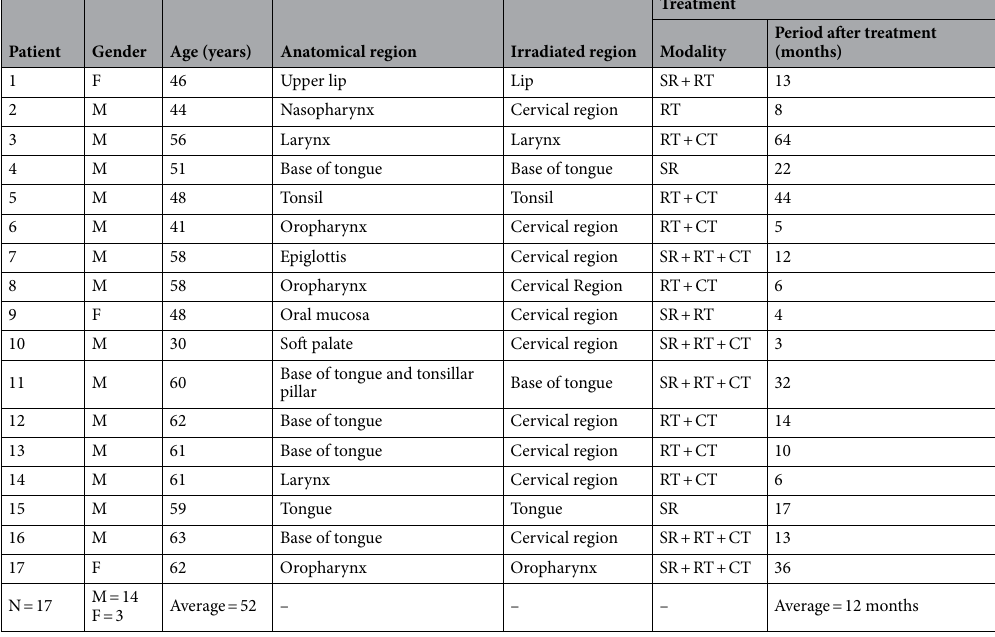
Table 1. Individual data from the sample after head and neck cancer treatment regarding their gender, mean age, anatomical region, and treatment. M male, F female, SR surgery, RT radiotherapy, CT